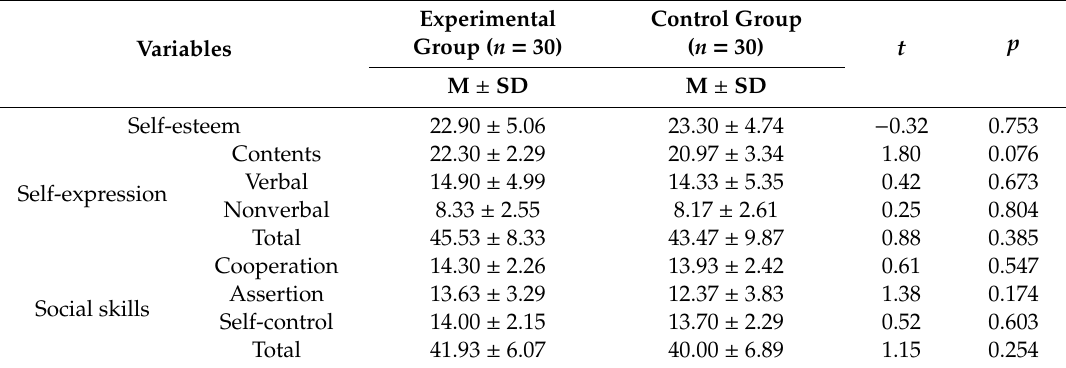
Table 3. Homogeneity of self-esteem, self-expression, and social skills between the groups.